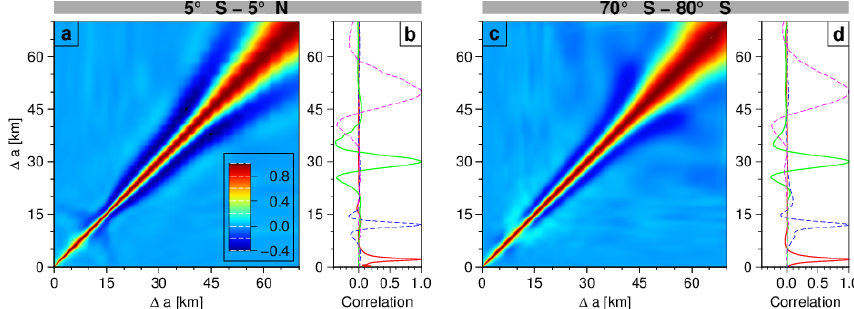
Figure 2. An example of forecast error correlation matrix made available through the NMC method. (a) Forecast error correlation in a 10 ◦ latitude bin (5 ◦ S–5 ◦ N), which is averaged along the longitude and during the months of July. The coordinate (cid:49)a indicates the distance (km) in the refractional radius from the lower bound. (b) Profiles of error correlation centered at four arbitrarily chosen heights. Panels (c) and (d) are the same as in panels (a) and (b) except for in 70–80 ◦ S